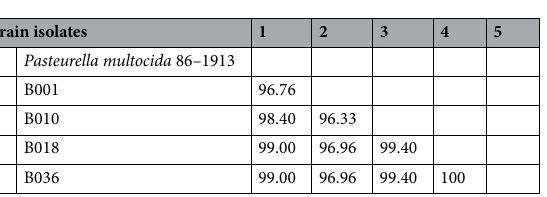
Table 3. The results of the test of the similarity level of the NanB gene isolate with Pasteurella multocida 86–1913 as a reference isolate.